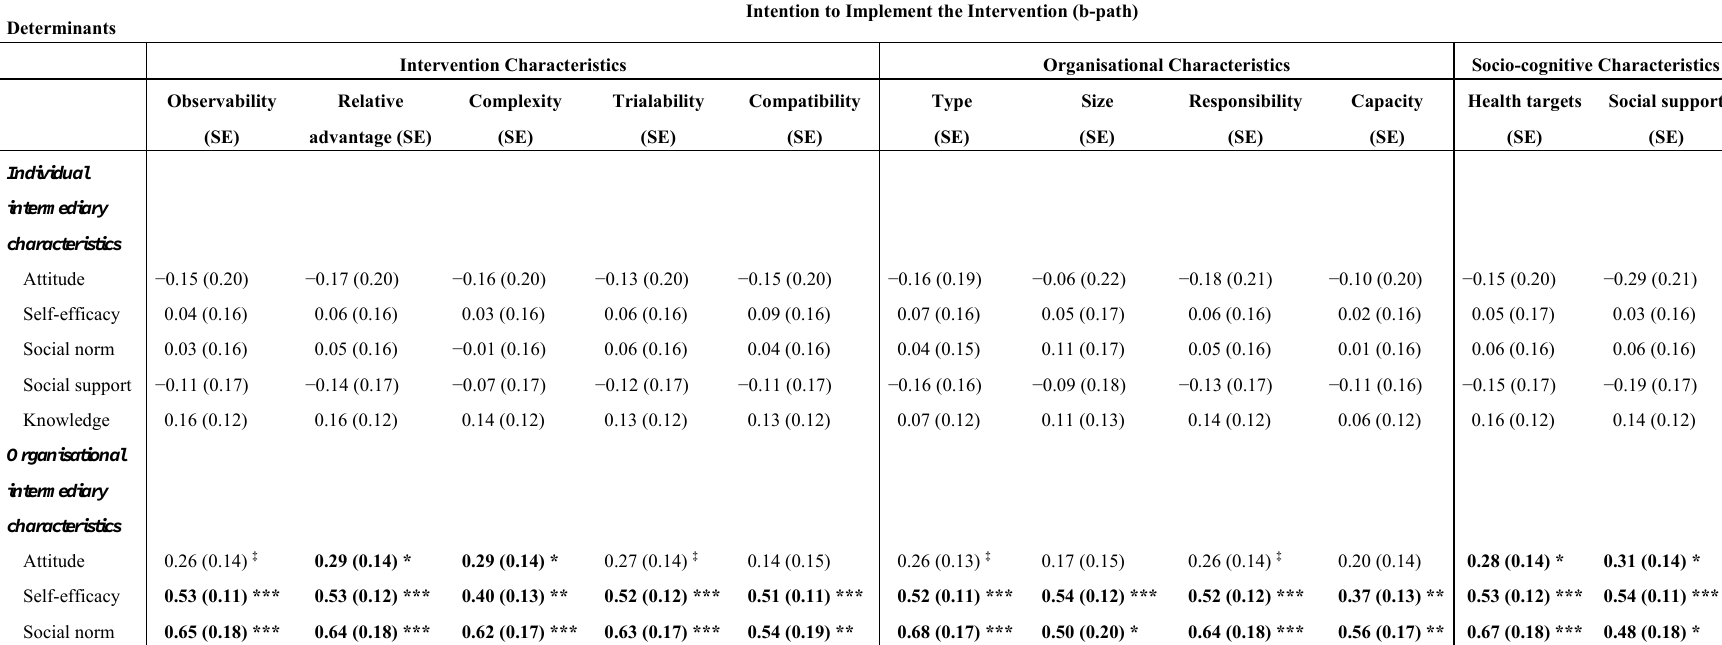
Table 4. Association between proximal factors and intention to implement the intervention